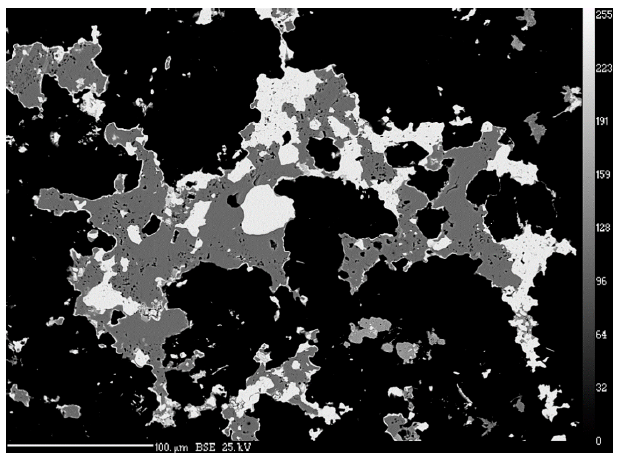
Figure 25. Light clausthalite in form of inclusions in dark chalcopyrite. BSE photo. P ř íbram, a dump of shaft 16. Photo by J. Sejkora and P. Škácha.